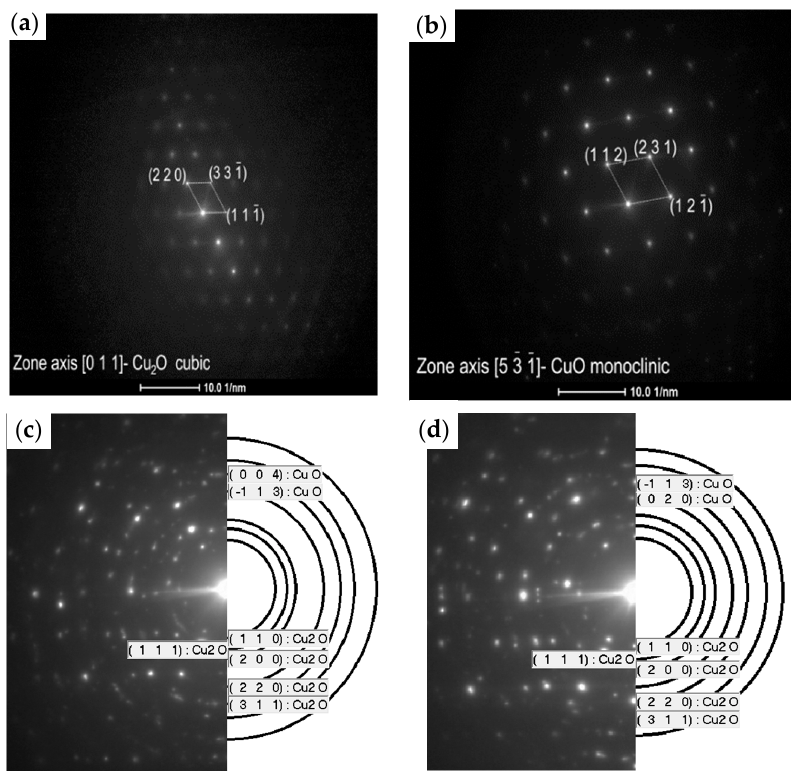
Figure 9. Selected area electron diffraction (SAED) patterns of the ( a ) middle layer and ( b ) top layer of the L1-1 sample and the ( c ) middle layer and ( d ) top layer of the L2-4 sample.